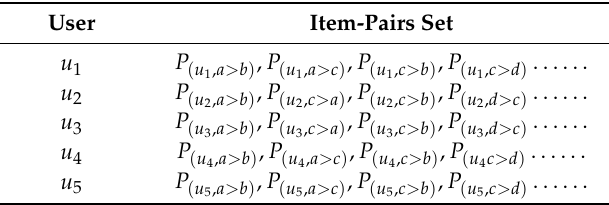
Table 4. User’s item-pairs